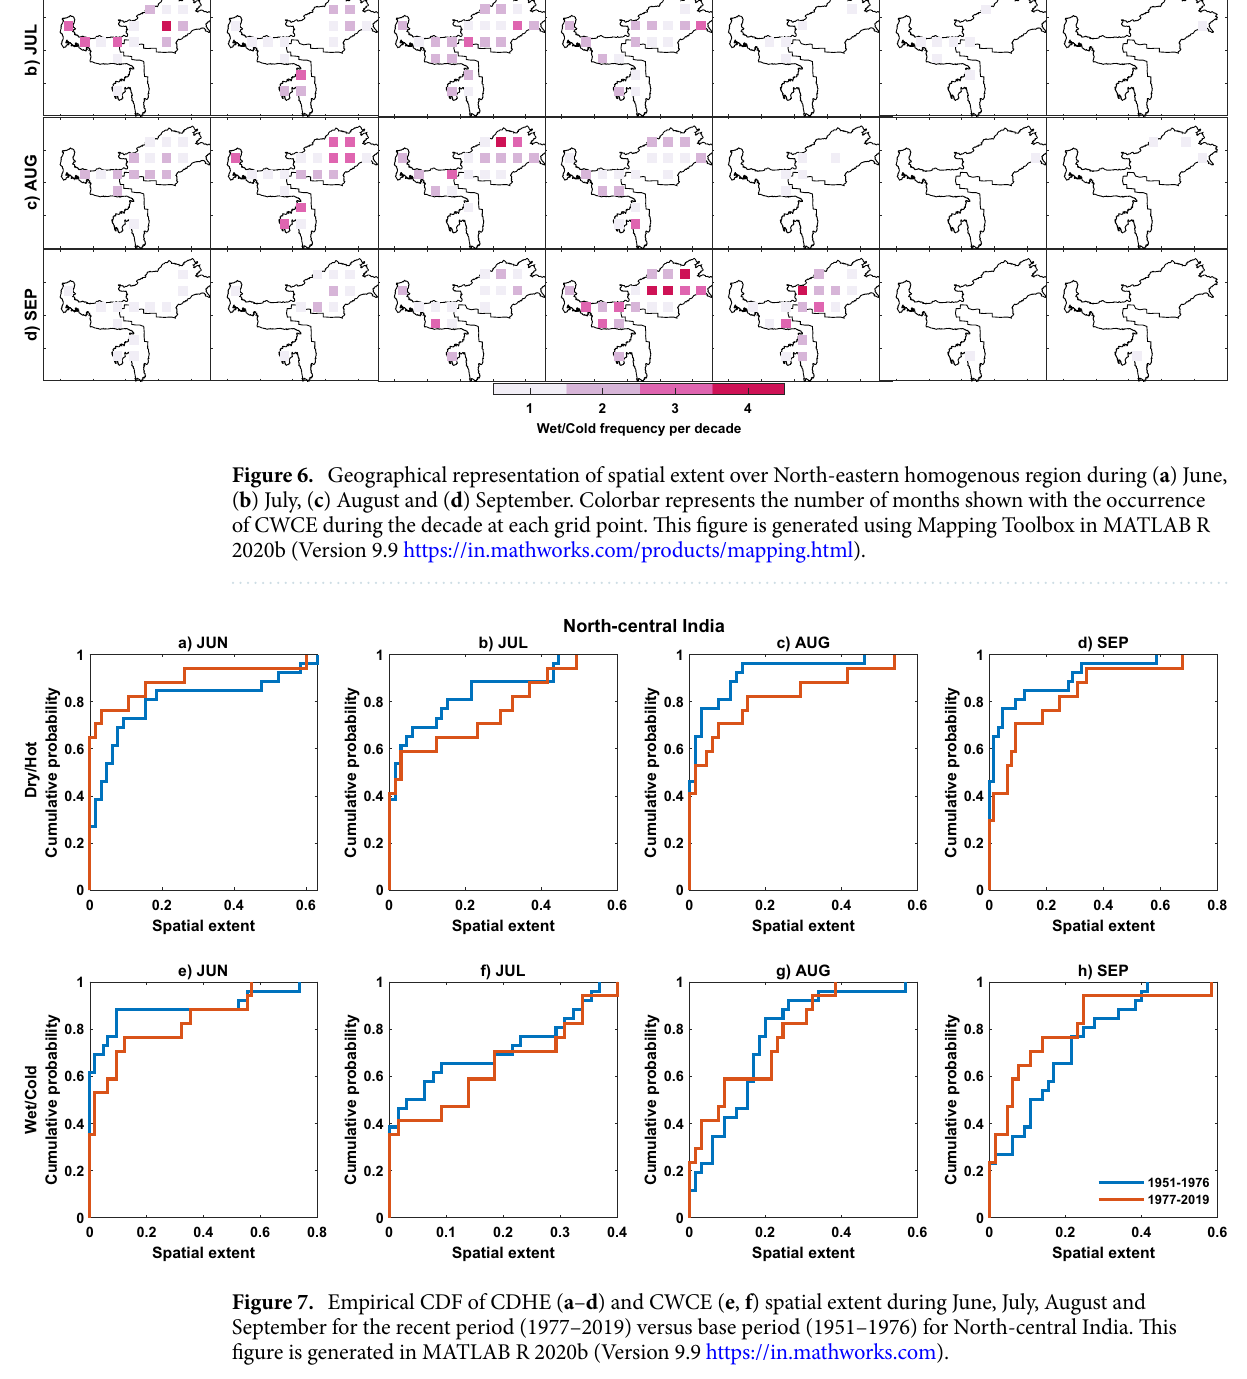
come from the same underlying continuous population. Results from the hypothesis testing are given in Table 3 to summarize the results, where H = 0 (1) states the hypothesis is accepted (rejected) at a 95% confidence level. For CDHE (top panel, Fig. 7) eCDF is plotted to illustrate the distribution of spatial extent values for the recent period (red line) and base period (blue line) for one particular homogenous region (North-central India). The additional supporting analysis for the rest of the homogenous region is shown in the supplementary information